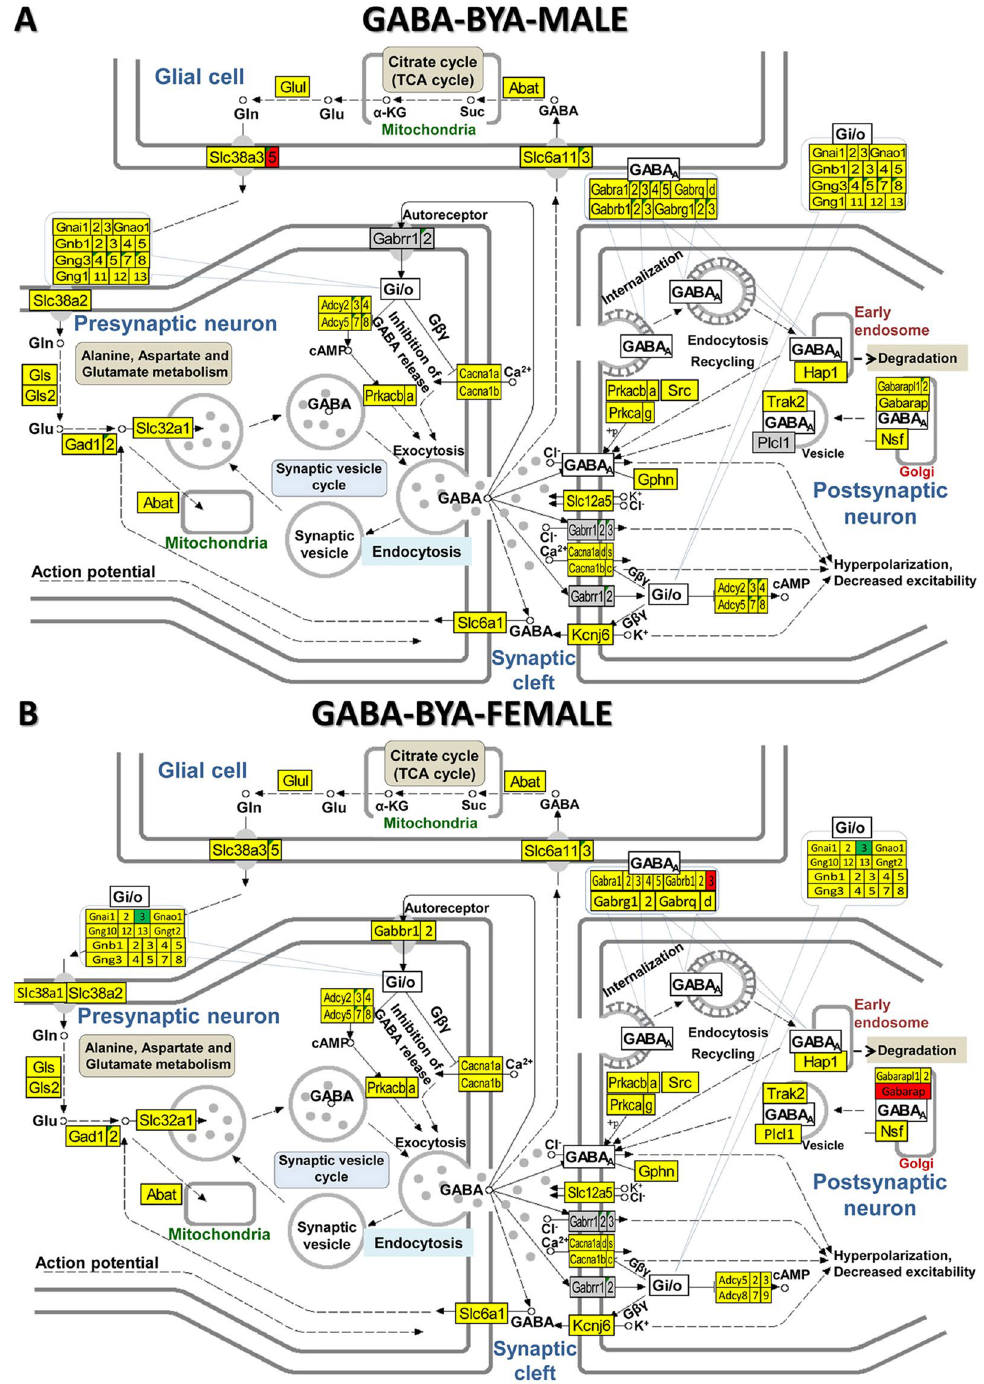
Figure 5. KEGG (www.kegg.jp/kegg/kegg1.html) map of regulation of the GABAergic synapse pathway in the arcuate nucleus of ACTH-treated betamethasone–primed male ( A ) and female ( B ) rats with NMDA-induced infantile spasms (BYA) compared to counterparts without spasms